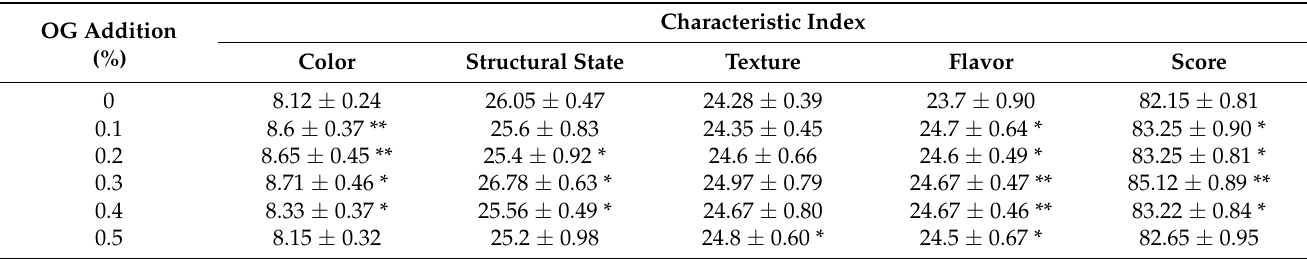
Table 1. Sensory evaluation of set-type yogurt.